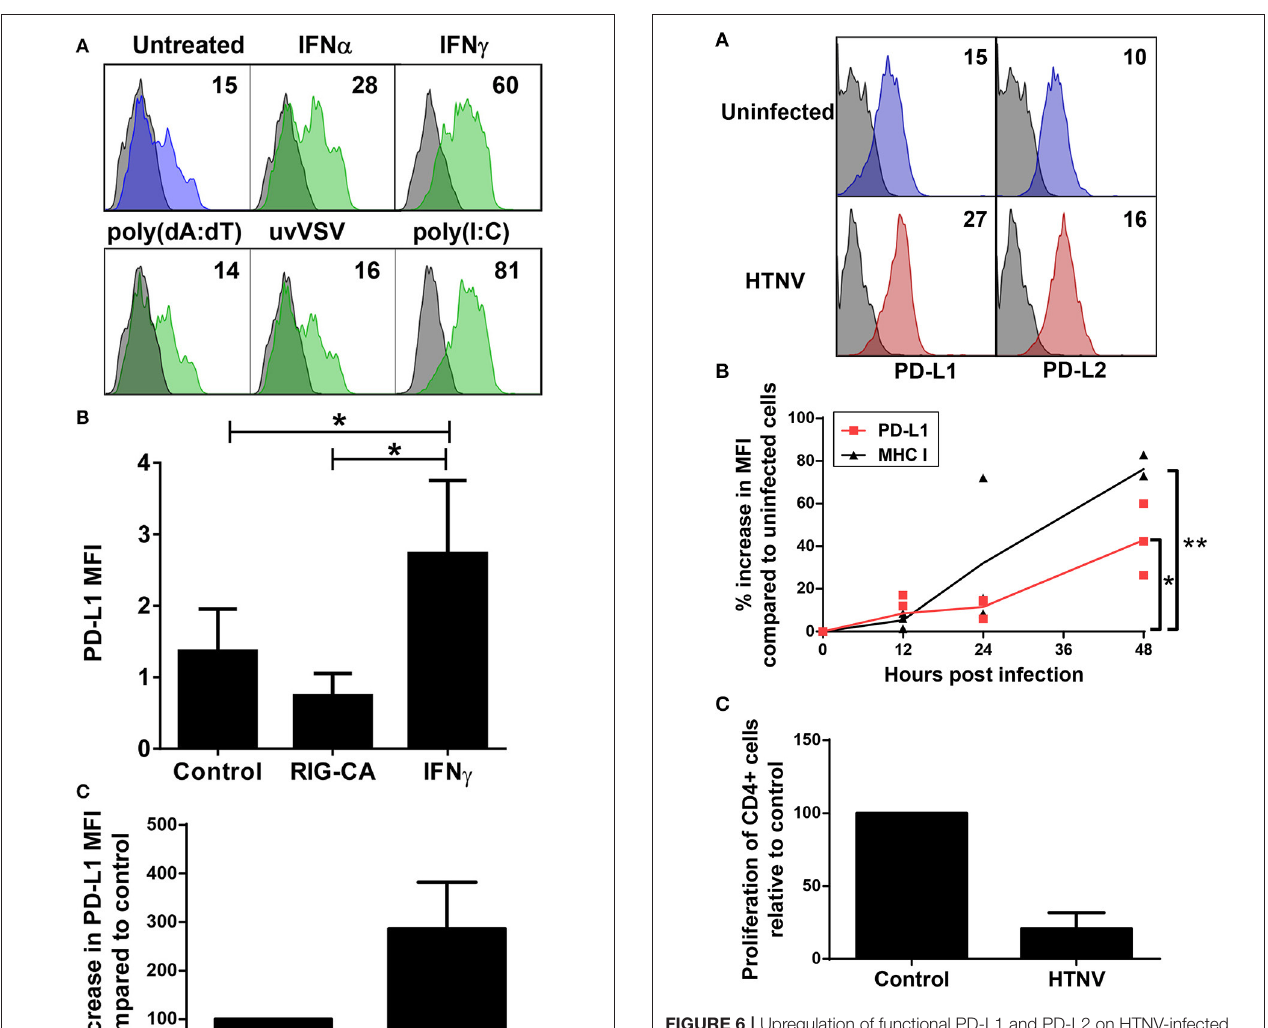
peptide derived from pp65 (CMVpp65TET) was used to detect HCMV-specific CD8 + memory T cells. After HTNV infection of PBMCs the percentage of CMVpp65TET + CD8 + T cells that expressed CD107a (LAMP-1), a marker for degranulation